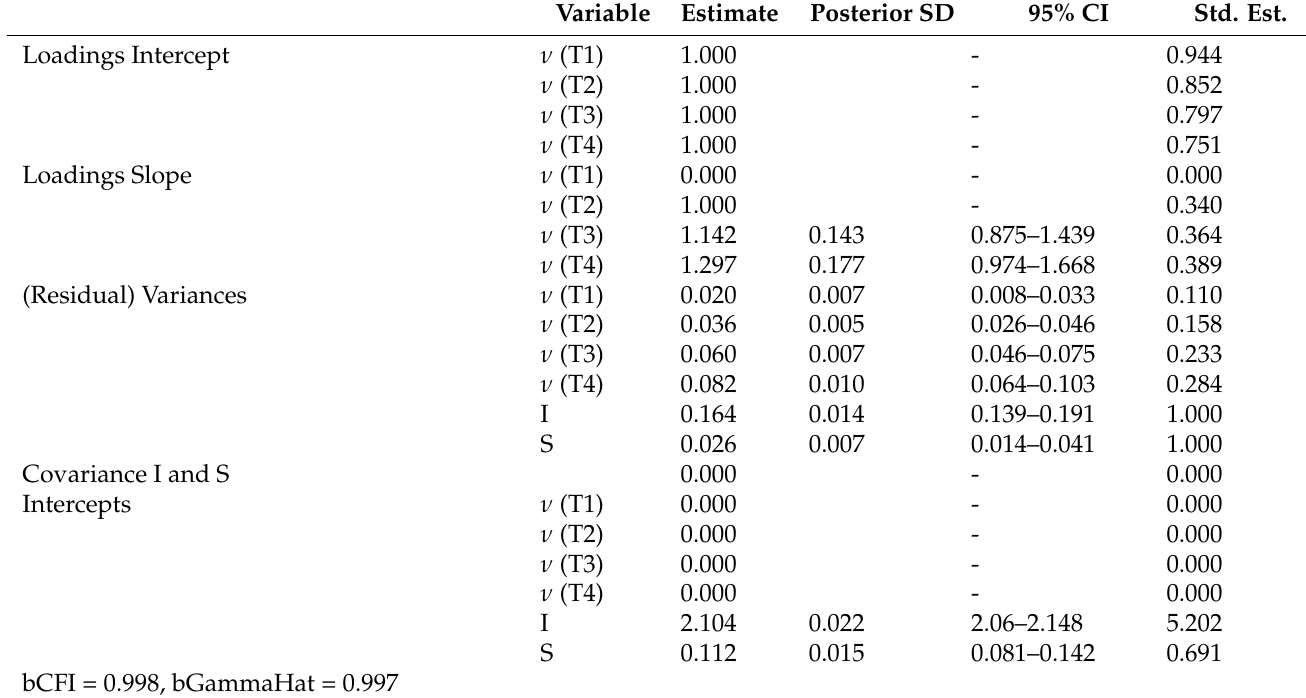
Table 3. Parameter estimates and model fit of the drift rate growth curve